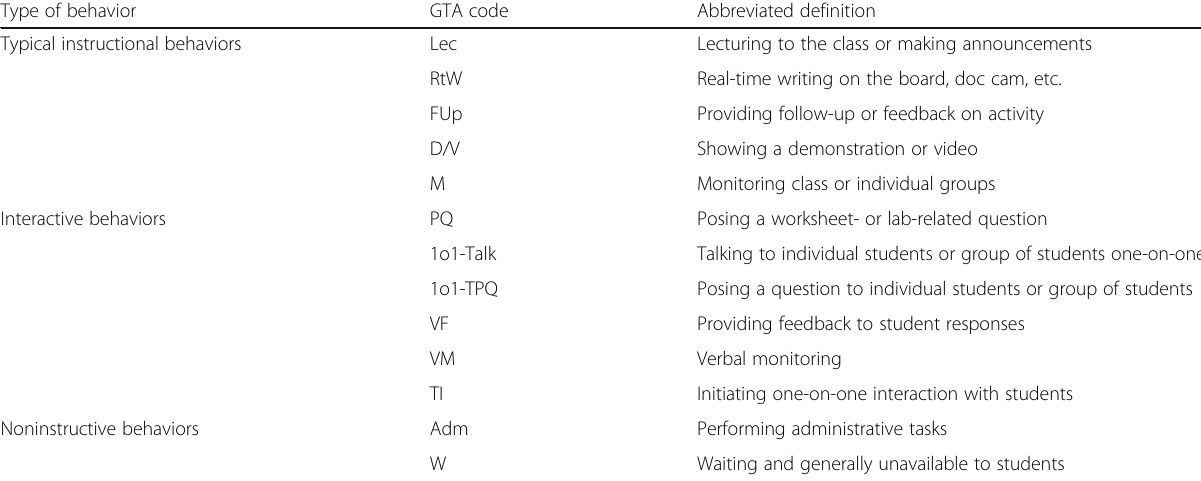
Table 2 Definitions for codes that describe GTA behaviors